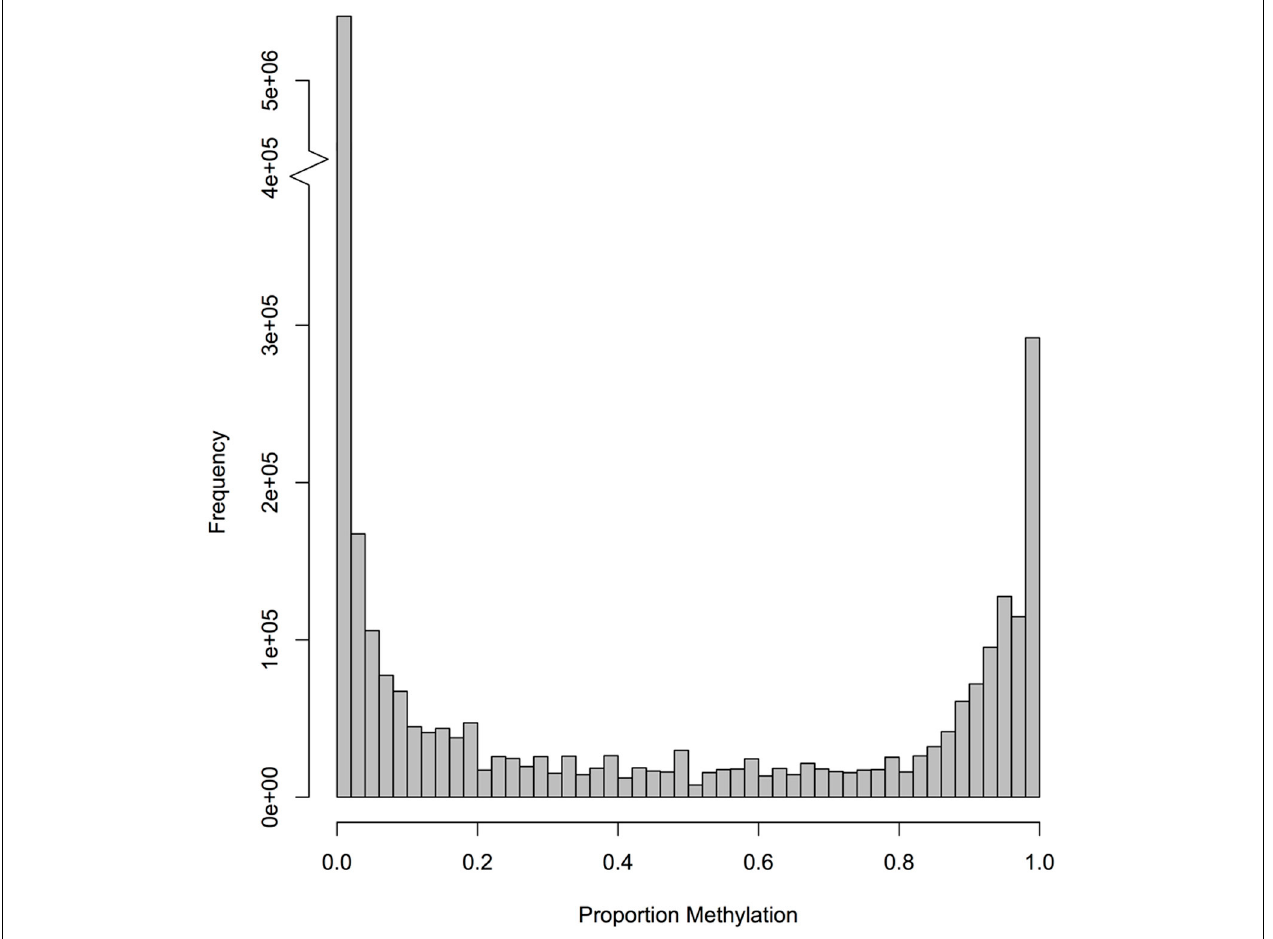
FIGURE 1 | Frequency of CpG methylation ratios in C. gigas male gamete tissue. A total of 7,642,816CpG dinucleotides with at least 5 × coverage were